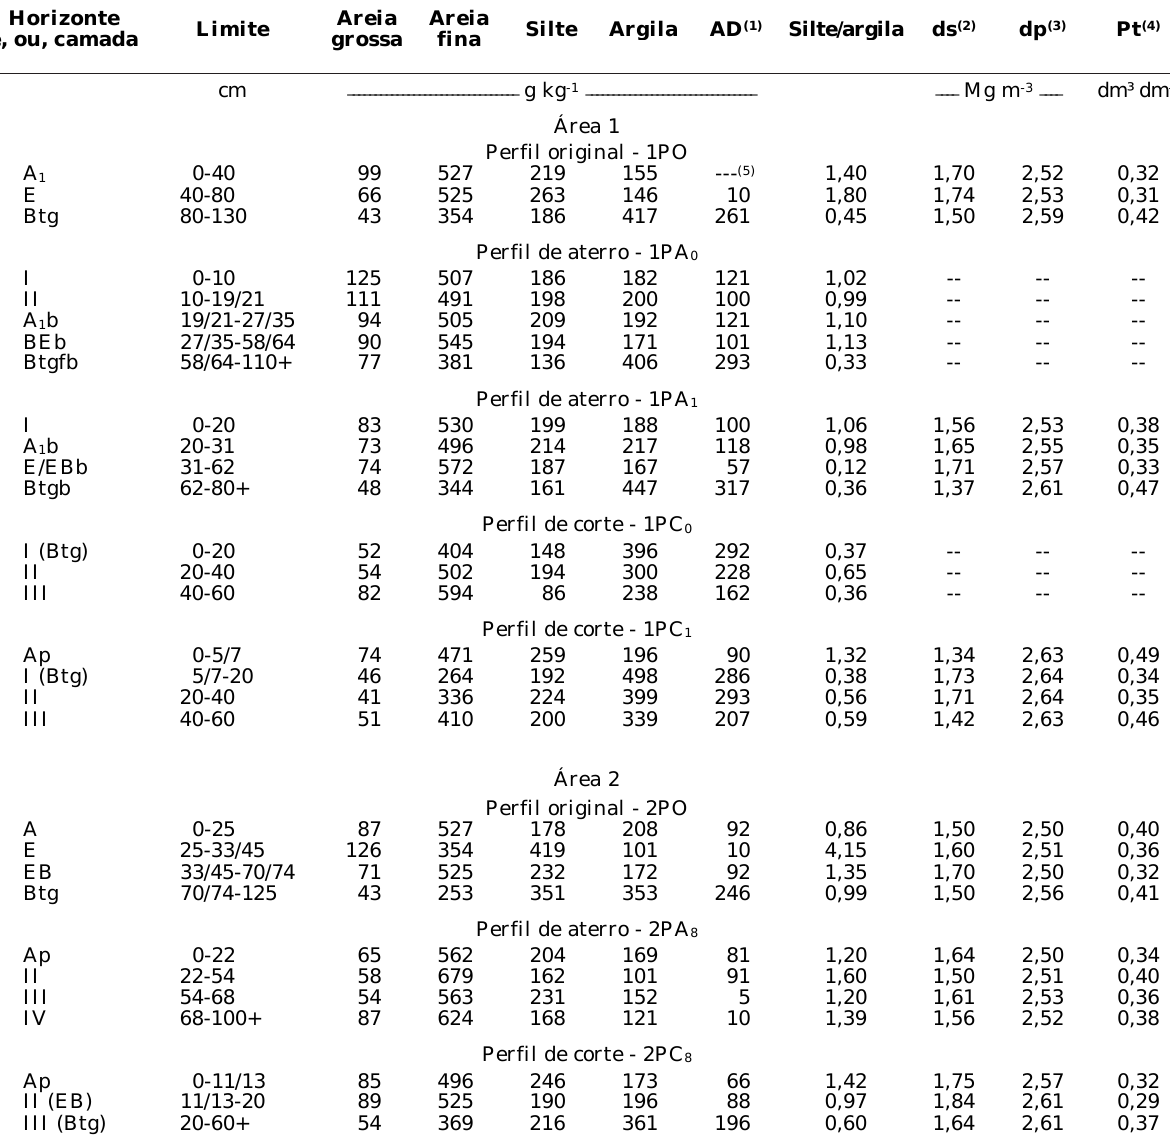
(1) AD = argila dispersa em água. (2) ds = densidade do solo. (3) dp = densidade de partícula. (4) Pt = Porosidade total. (5) Não